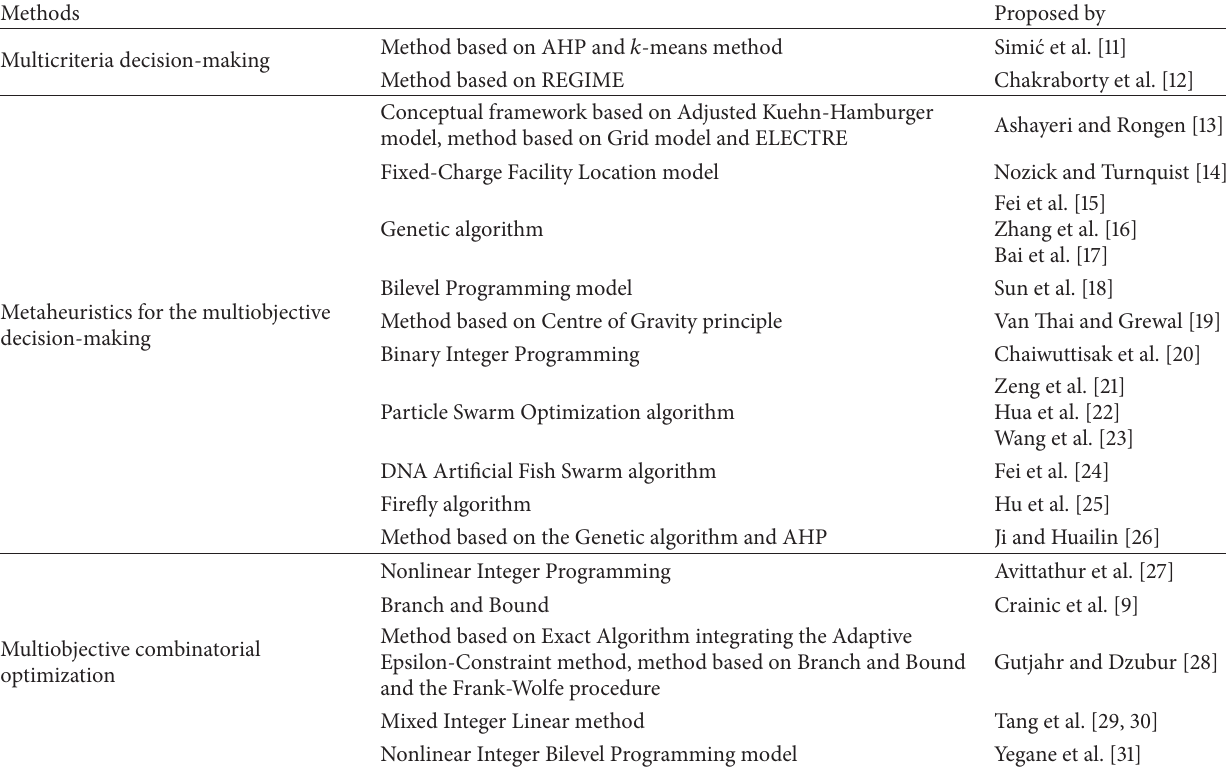
Table 1: The proposed methods for location selection of distribution centers under